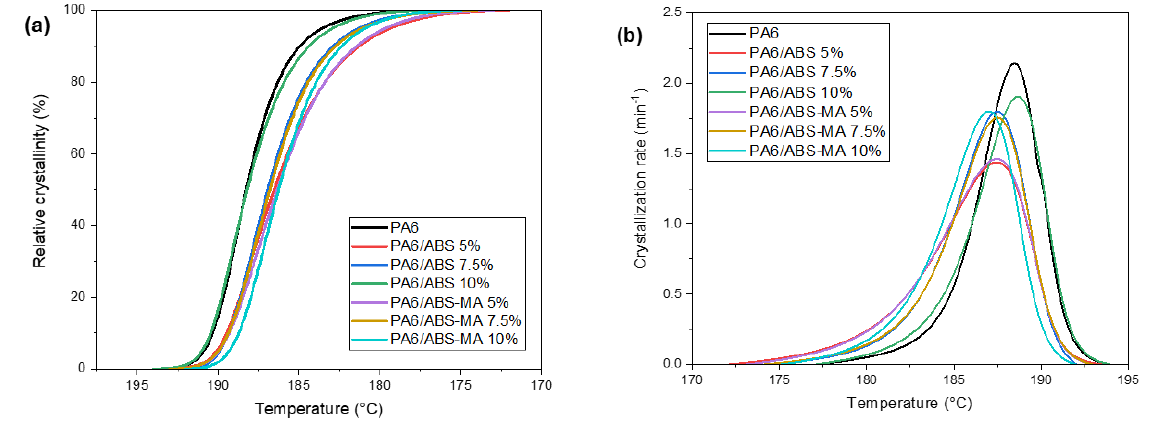
Figure 15. ( a ) Crystallization rate; ( b ) crystalline fraction.